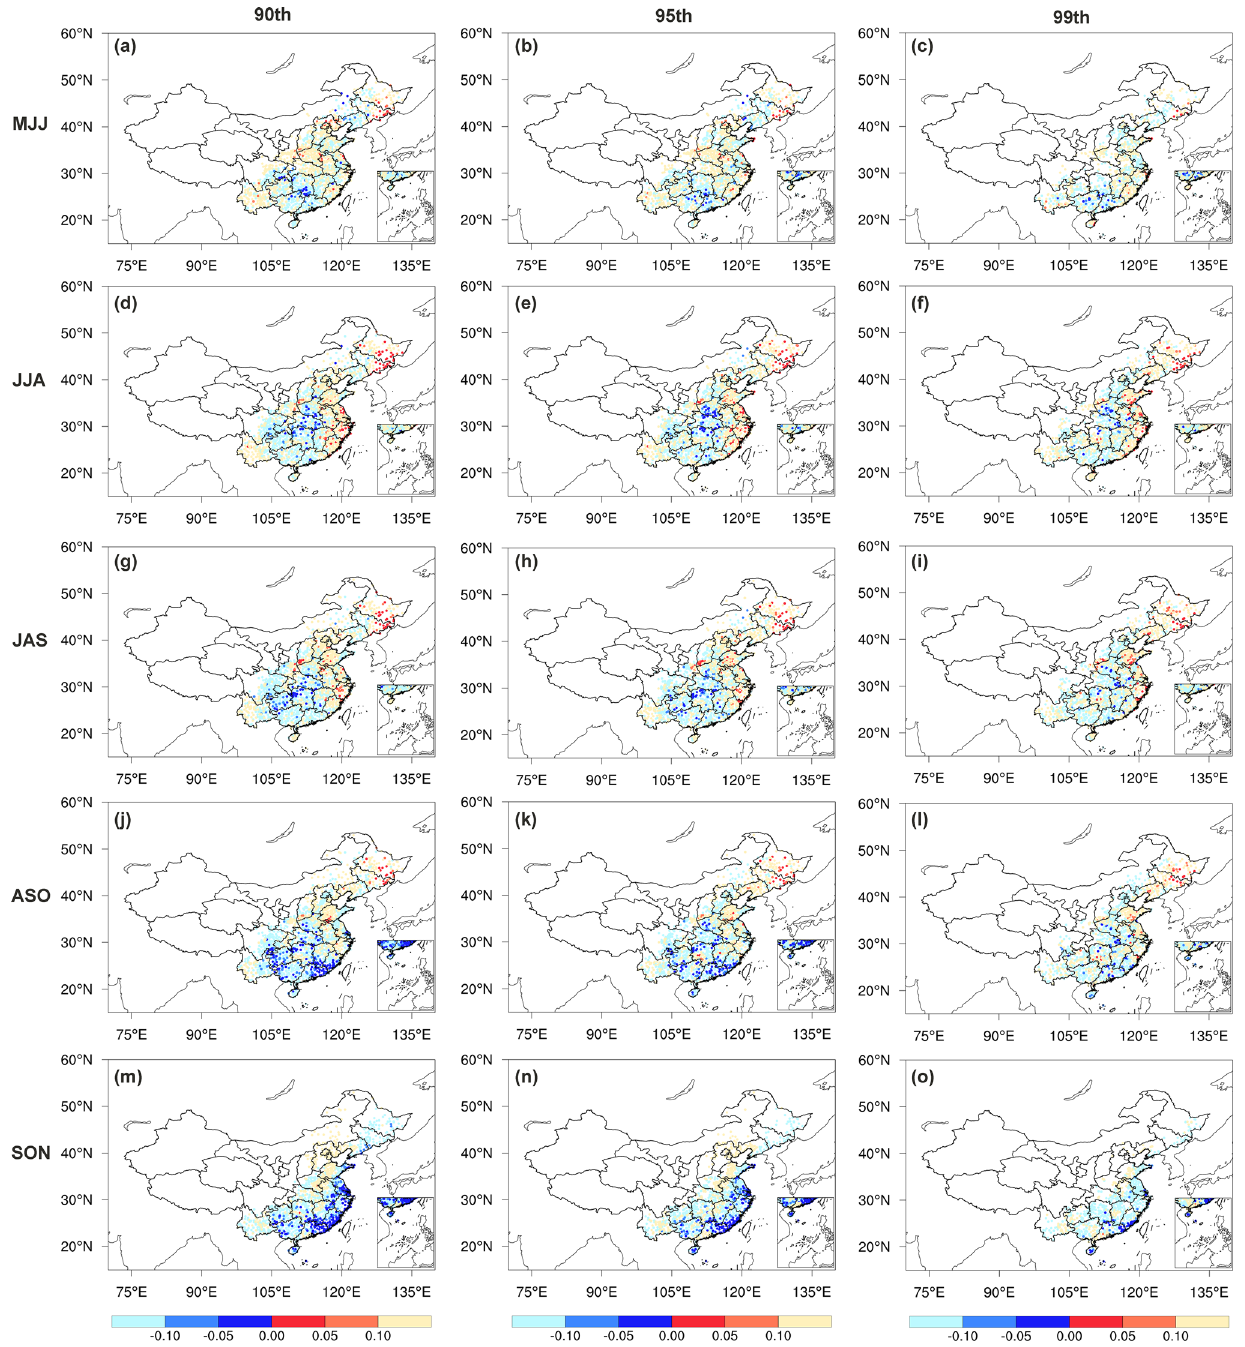
Fig. 8 Relationship between the frequency of tropical cyclone (TC)- induced extreme precipitation obtained by peak-over-threshold (POT) sampling and seasonal Nin˜o-3.4 values in the mainland of China. The relationship was identified based on Poisson regression, and the colors are p values of the b 1 coefficients. Negative p values (blue circles) represent that the b 1 coefficients are less than zero, indicating a